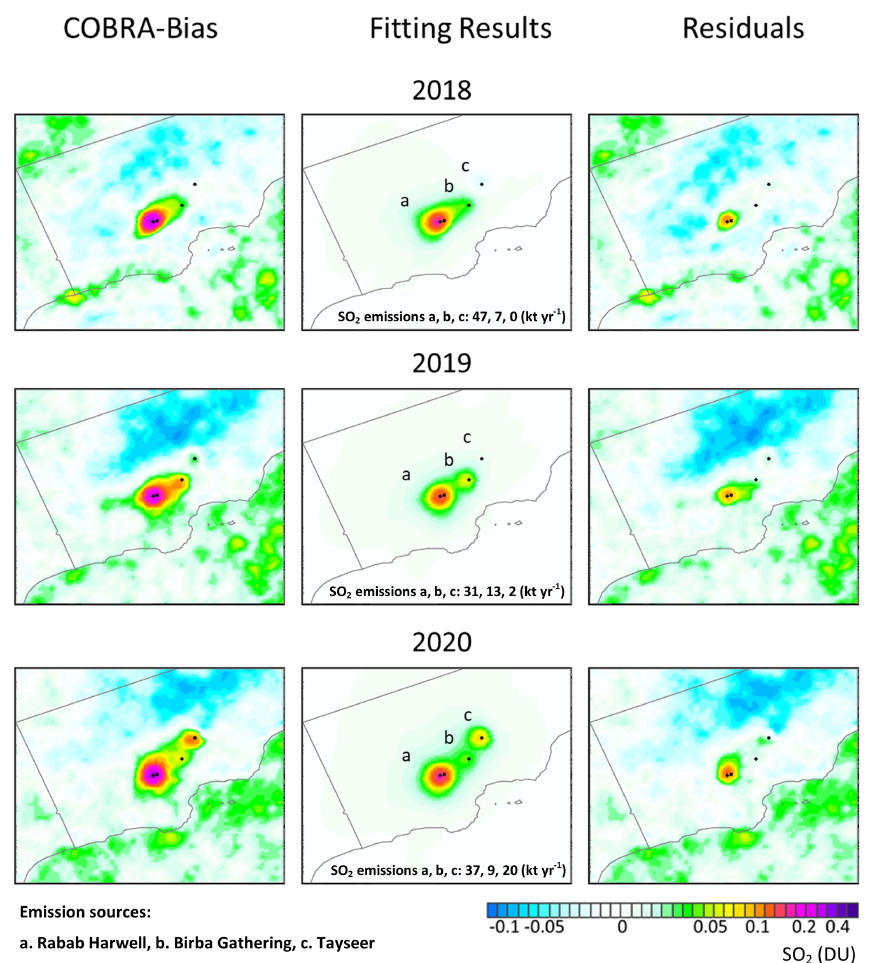
Figure 8. The left column shows yearly mean TROPOMI SO 2 columns retrieved from COBRA over southern Oman for 2018 (April to December), 2019, 2020 (from top to bottom), and after bias correction for the effect of elevation (see text). Three distinct SO 2 spots are discernable from the maps and are the results of emissions from oil and gas fields, referred to as Rabab Harwell, Birba Gathering and Tayseer (centre column), and results of the fitting of TROPOMI SO 2 data. The estimated annual SO 2 emissions (given in the inset for the three sources) are used to reconstruct the SO 2 column field (right column) residuals of the fit or the difference between TROPOMI and fitting